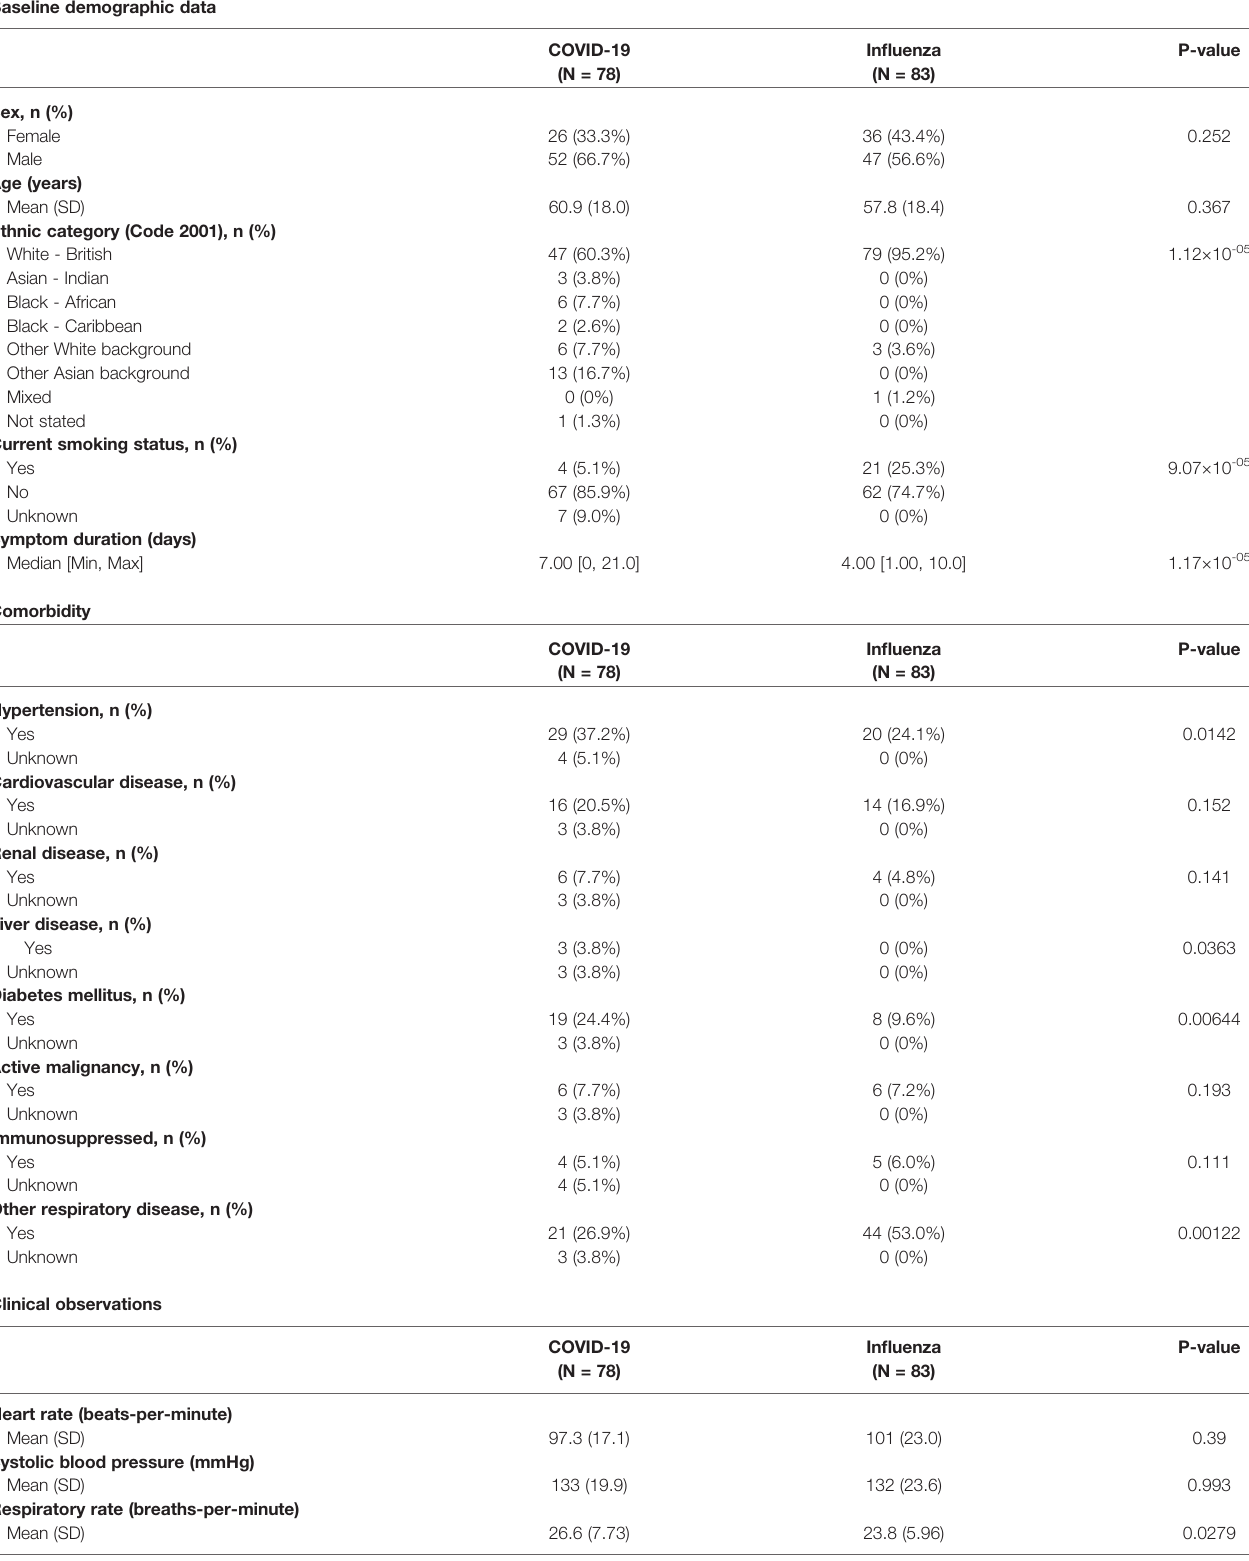
TABLE 1 | Baseline clinical characteristics and outcomes of hospitalised patients with COVID-19 or in fl